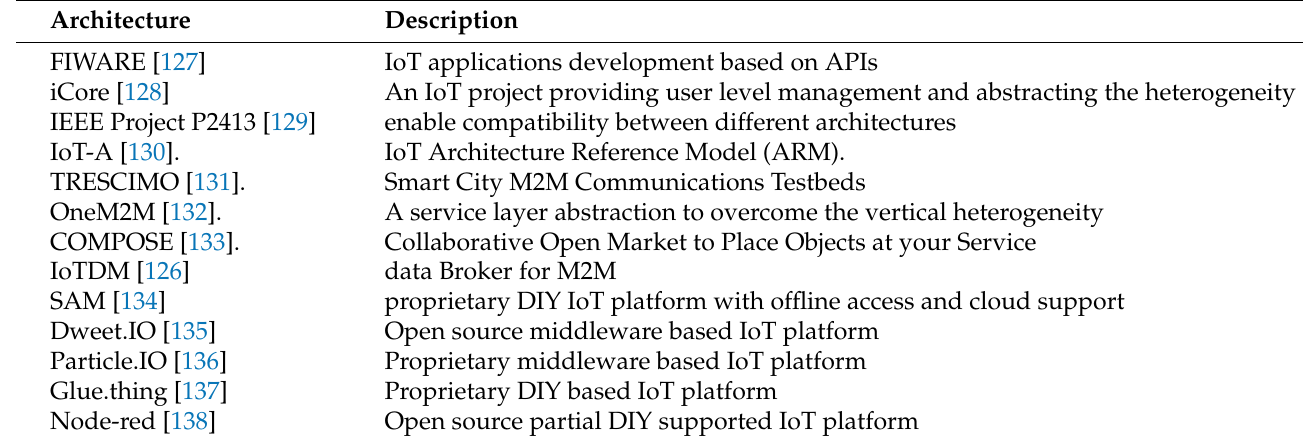
Table 4. IoT architectures initiatives.